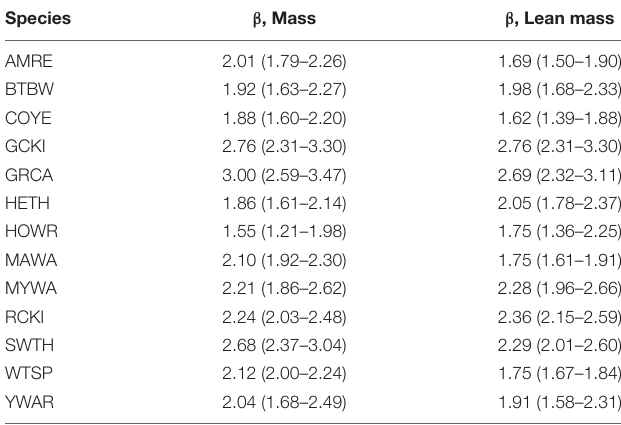
TABLE 3 | Exponents (with 95% confidence interval) in body mass and lean mass scaling relationships with wing chord for songbirds stopping over at Long Point,